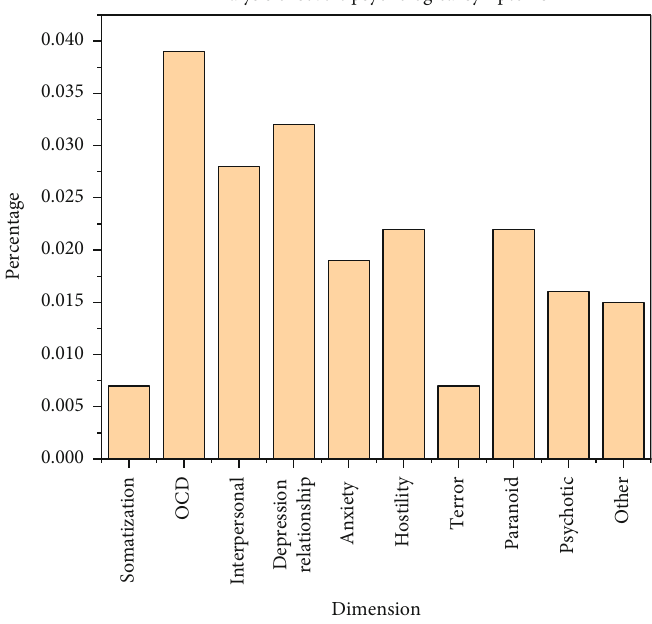
Figure 8: Analysis of severe mental